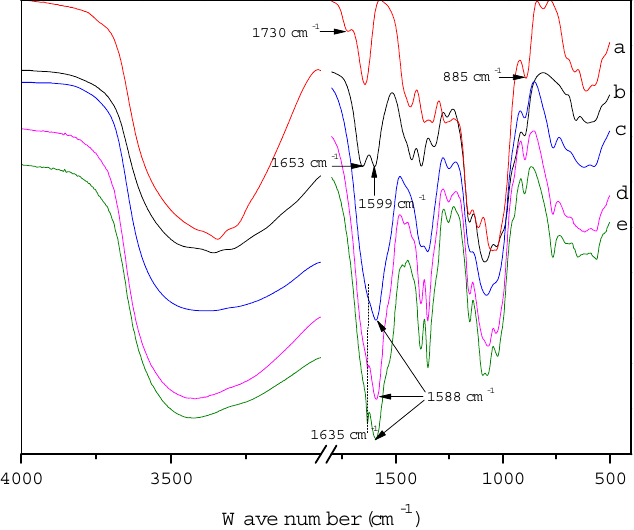
Figure 1. FT-IR spectra of ( a ) DACNC; ( b ) CS; ( c ) CNC/CS3; ( d ) CNC/CS2; ( e ) CNC/CS1.